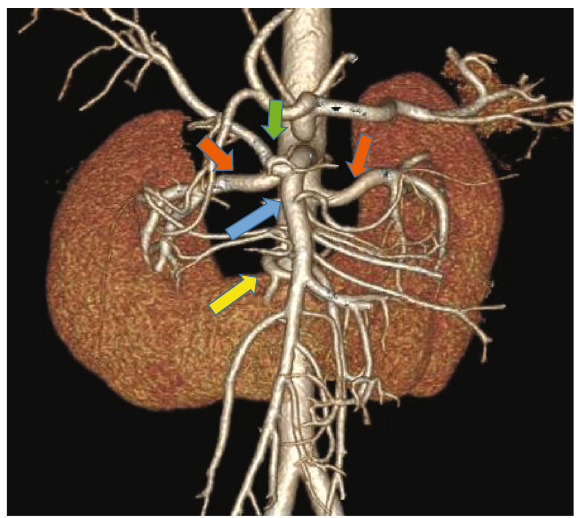
Figure 1: CT angiographic reconstruction of the vascular anatomy of the horseshoe kidney. Yellow arrow: the lower polar artery supplying the lower poles of both kidneys and the isthmus. Red arrows: the right and left main renal arteries. Blue arrow: superior mesenteric artery (SMA) originating from the aorta in very close proximity to the right renal artery. Green arrow: replaced right hepatic artery arising from the SMA.